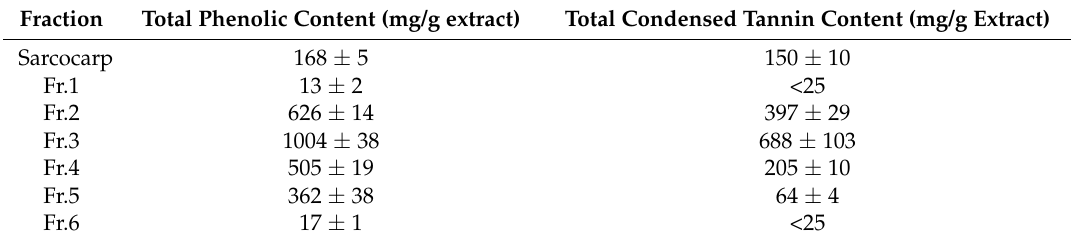
Table 1. The total phenolic